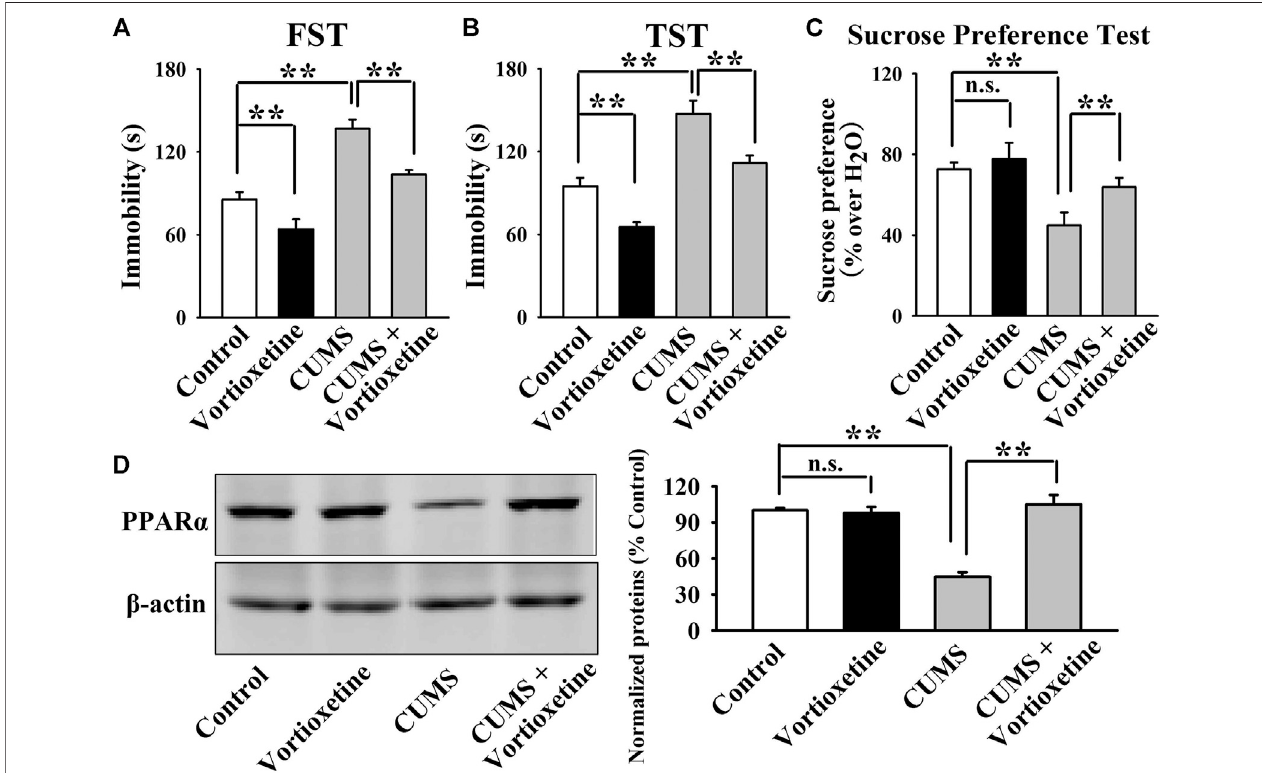
FIGURE 1 | The CUMS-induced decrease in the hippocampal PPAR α expression was signi fi cantly reversed by repeated vortioxetine treatment. (A – C) The antidepressant effects of vortioxetine in the CUMS model, as detected by the FST, TST and sucrose preference test. C57BL/6J mice subjected to 8 weeks of CUMS weredailyinjectedwithvehicle/vortioxetineduringthelast2 weeks,andthensubjectedtobehavioraltests. (D) Representativeimagesandquantitativeanalysesindicate that vortioxetineadministration fully antagonized the inhibitory effects ofCUMS on thehippocampal PPAR α expression. For (A – C) , n (cid:2) 10per group; For (D) , n (cid:2) 5 per group. The data are expressed as the means ± S.E.M.; ** p < 0.01; n.s., no signi fi cance. The comparisons were made by two-way ANOVA followed by Bonferroni ’ s test.